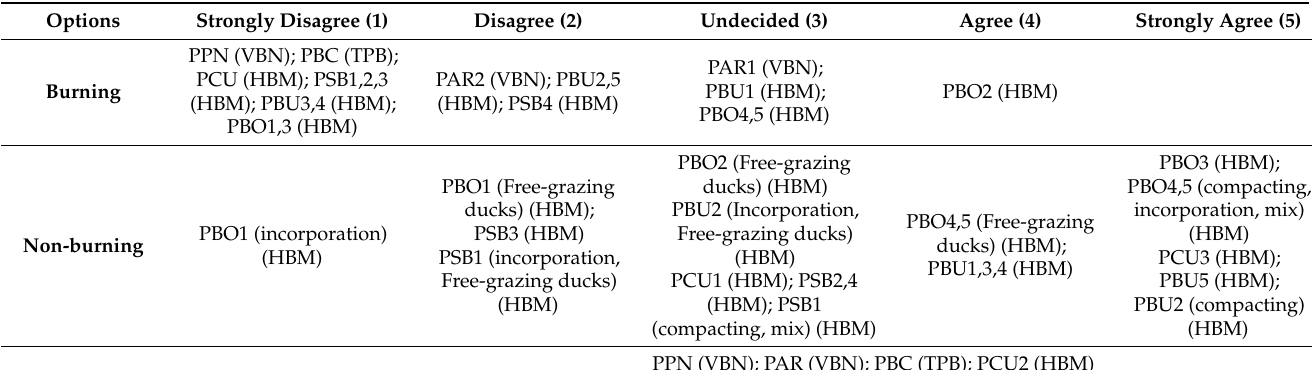
Table 4. Summary of rice straw management options, influencing psychological factors and be- havioural theories